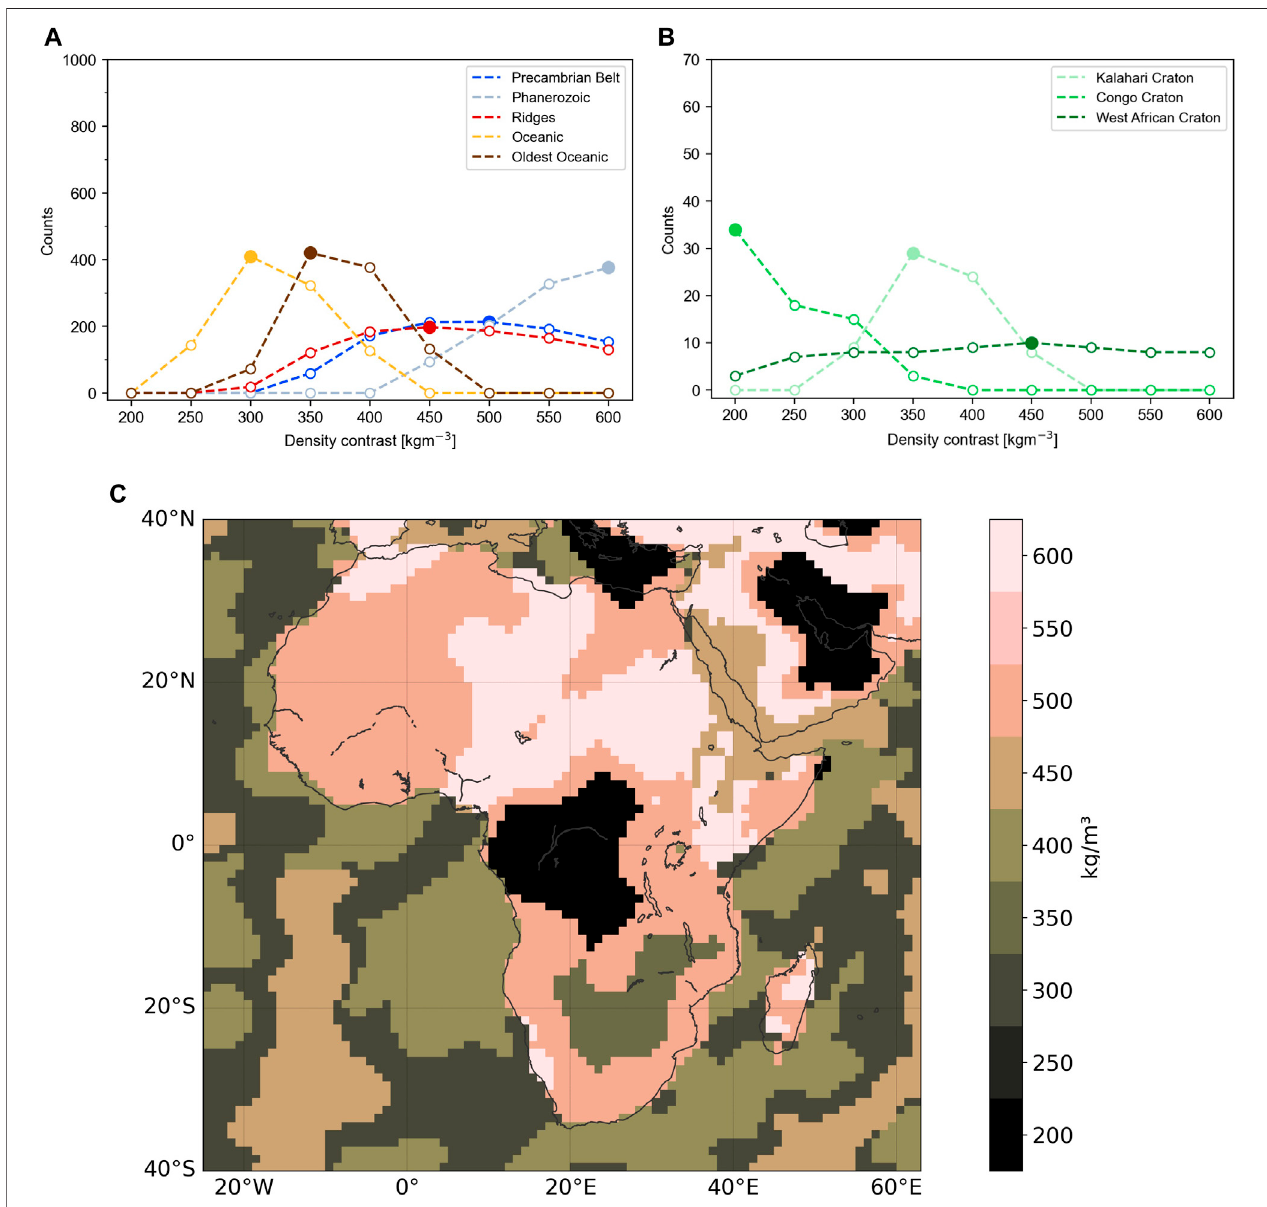
FIGURE5|(A) Distributionofthedensitycontrastsforthe1,000best- fi ttingmodelsofthe fi rstinversionstep. (B) Distributionofthedensitycontrastsinthesecond inversion step. Due to a limited number of model solutions only 70 models are compared with each other. Both distributions are shown for the combined RMS of both constraints. (C) Final estimated density contrasts at the Moho depth for the best- fi tting model in a gridded space.